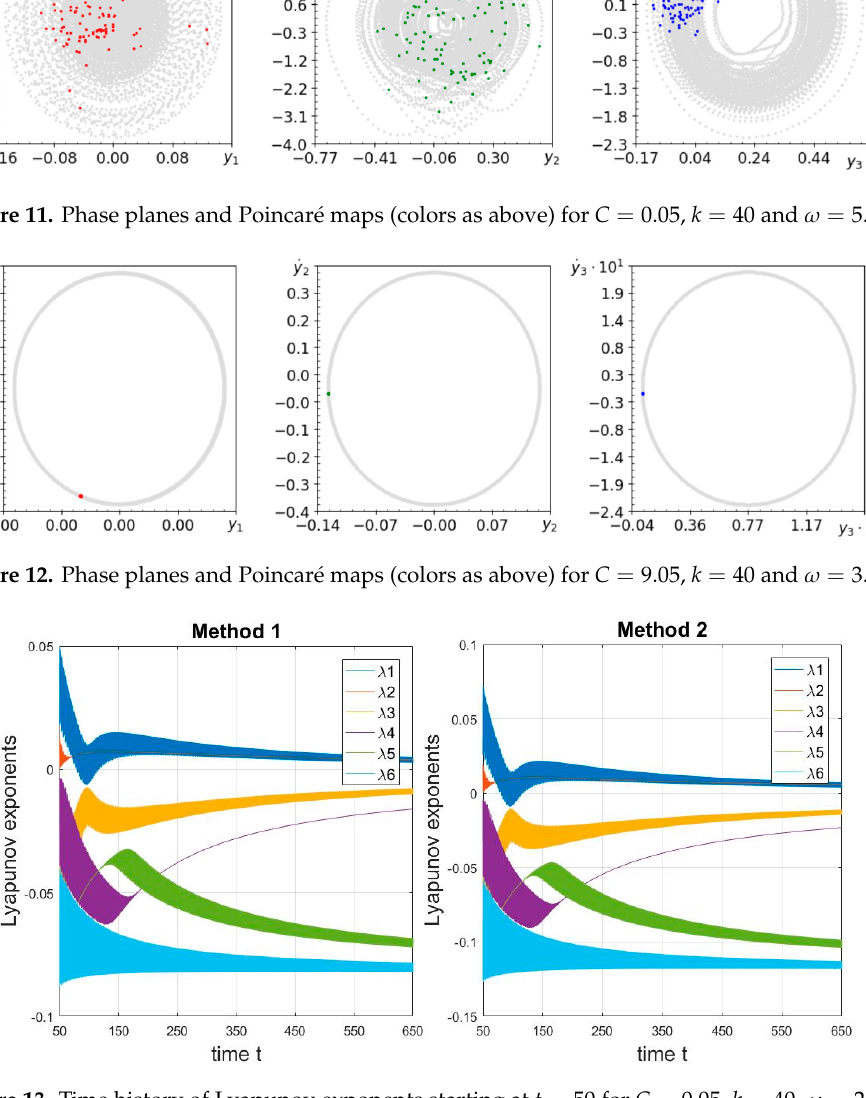
Figure 14. Time history of Lyapunov exponents starting at (cid:1872) = 50 for (cid:1829) = 9.05 , k = 40 and (cid:2033) = 3.14 . 4.4. Observation of Similarities in the Behaviour of Systems with a Rigid Pendulum and Its Mutations In this section, we present the results for a special case when all the analyzed systems behave in a similar way. In the case of the second system, the amplitude of the pendulum length is A = 0.001, while the parameters of the third system are as follows, k = 2000 and C = 0.05. The previously presented spectra of Lyapunov exponents have proved that the most accurate results are obtained for a longer observation time, therefore in this part only the results for time (cid:1872) (cid:2868) = 650 are presented. Figures 15–17 show the behavior of the second system, while the spectrum of Lyapunov exponents can be found in Table 6.